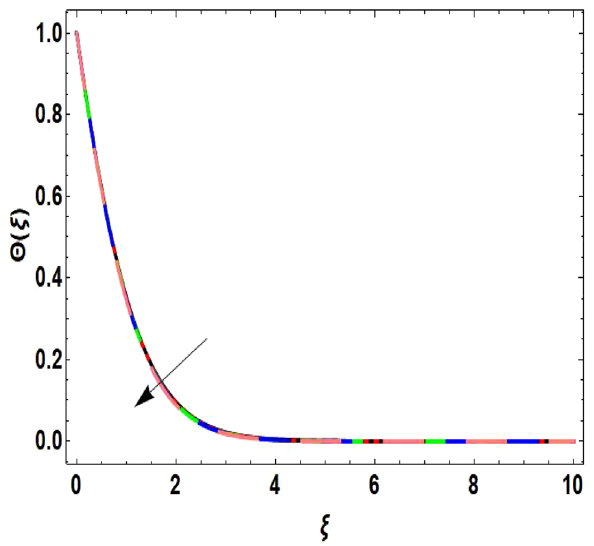
Figure 2. Temperature curve relative to exponential viscosity when A = 0.5, 2.5, 5.0, 7.0, 10.0.